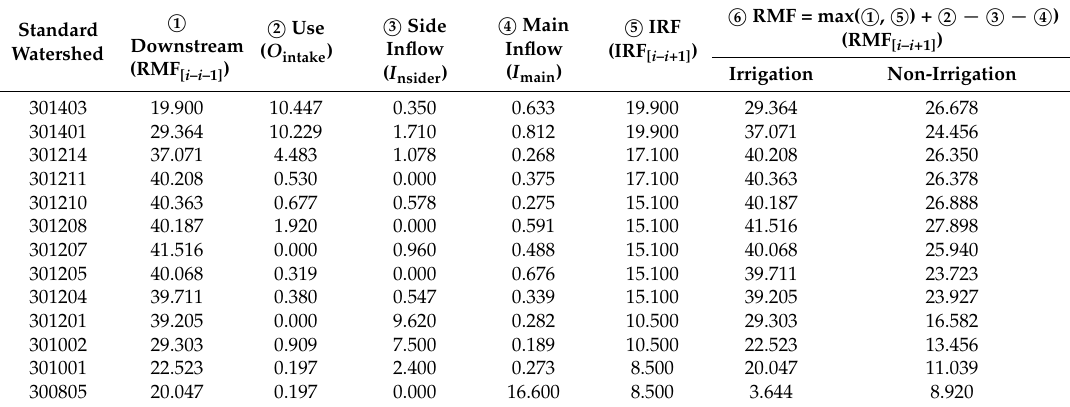
Table 2. Calculation of RMF (m 3